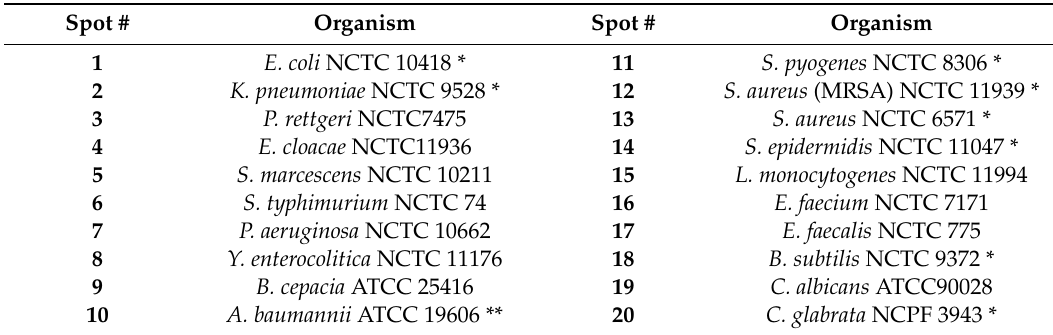
Table 2. Selected species for multispot inoculation. The spot numbers correlate to the numbered plate in Figure 3a.